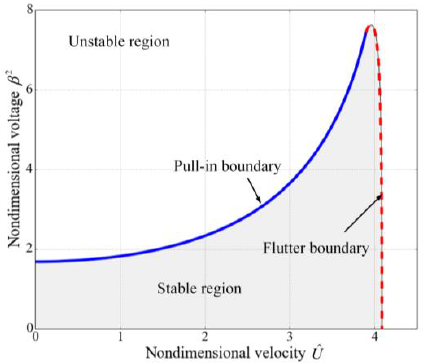
ˆ, U ) plane for the suspended microchannel resonators.